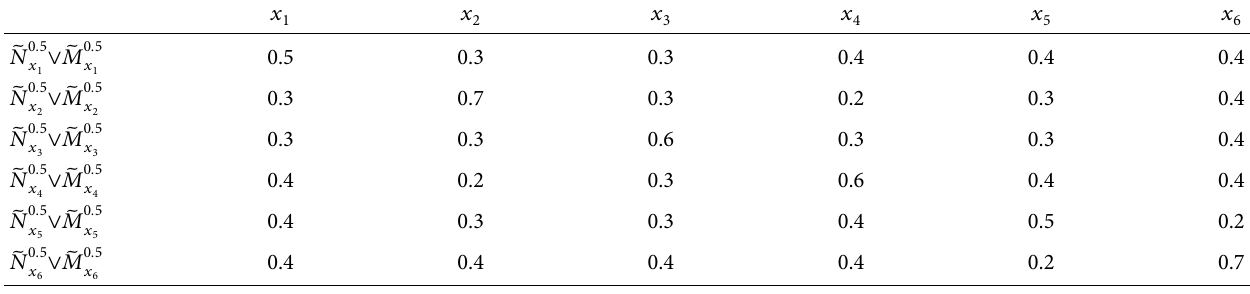
􏽥 C 􏽥 M β x i ∨ x i of 2